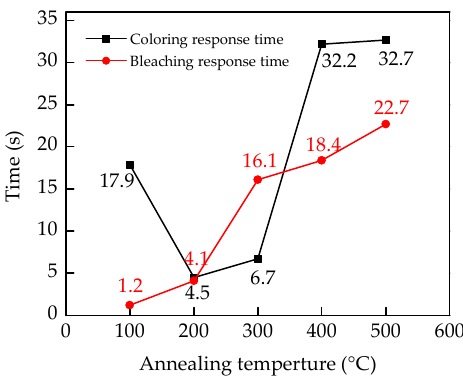
Figure 5. The curves of coloring and bleaching response time versus annealing temperature. The time corresponding to 90% of the total transmittance change is defined as the electrochromic response time.